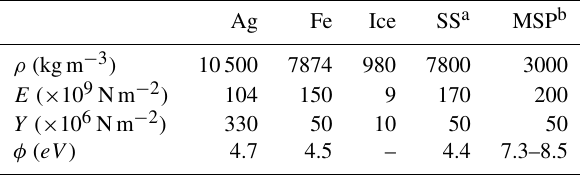
Table 1. Material properties used in the calculation of contact charg- ing yields for silver (Ag), iron (Fe), water ice, stainless steel (SS) and a meteoric smoke analogue